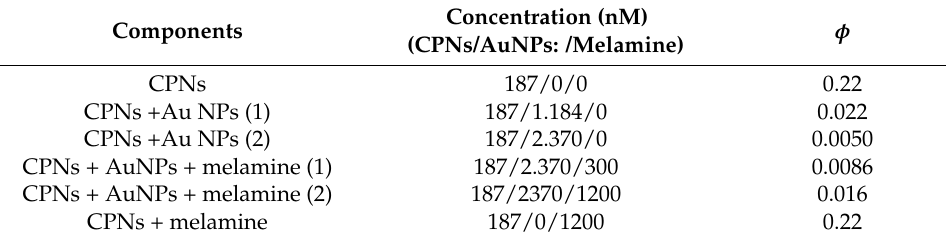
Table 2. The fluorescence quantum yields of CPNs under difference conditions.